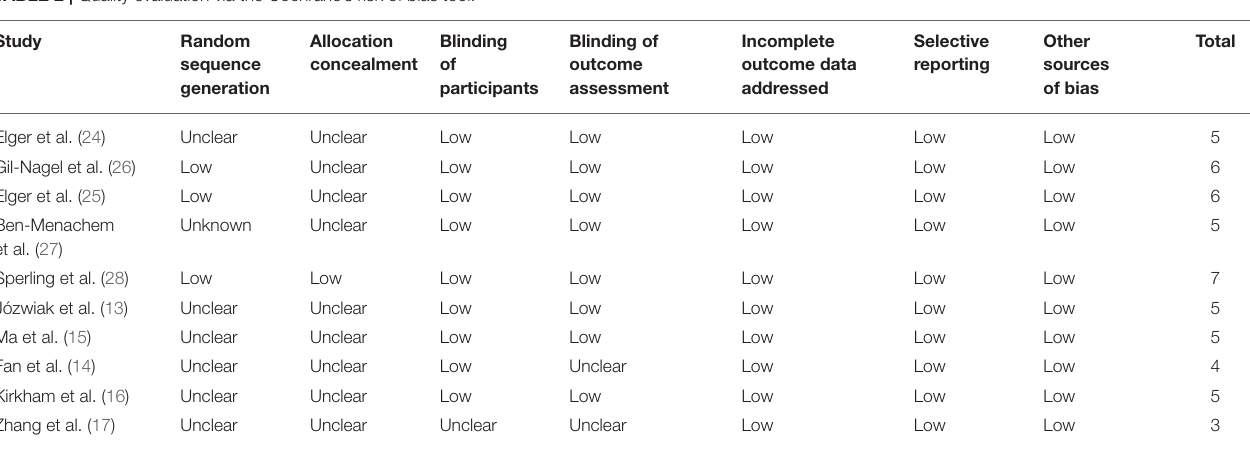
TABLE 2 | Quality evaluation via the Cochrane’s risk of bias